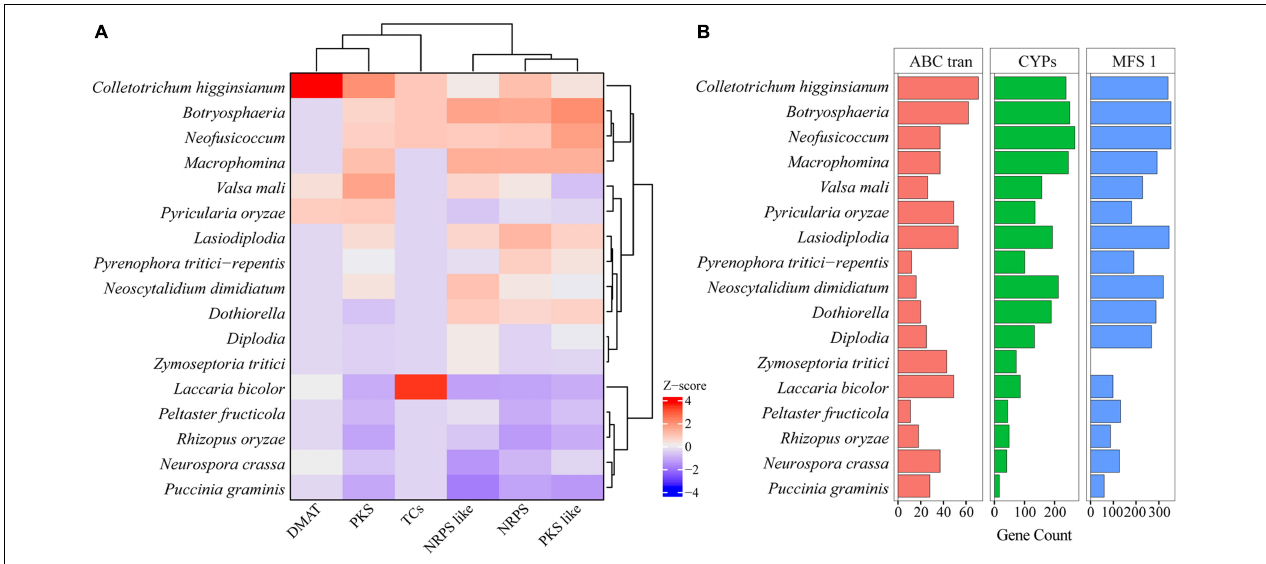
FIGURE 4 | Comparing backbone and related genes of secondary metabolism among Botryosphaeriaceae fungi and other 10 fungal species. (A) Key gene family of secondary metabolism. In each column, Z-score was used to describe the trend of over-represented (+ 4–0) and down-represented (0 to − 4) gene family. (B) Gene family number comparison of MFS_1, ABC_tran and CYPs among Botryosphaeriaceae fungi and other 10 fungal